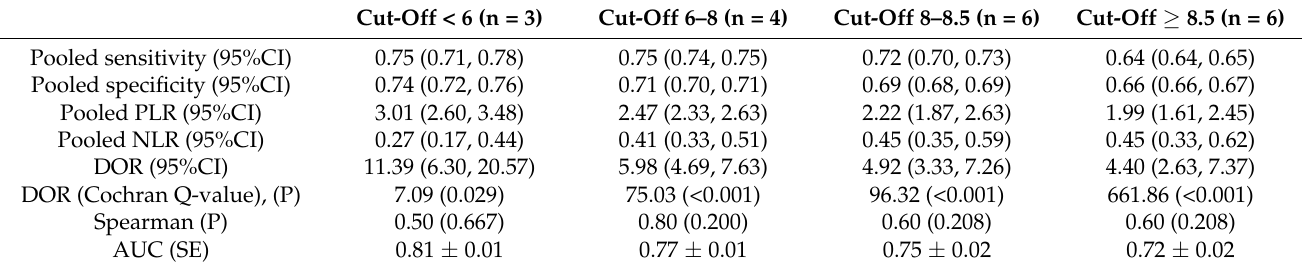
Table 4. Summary diagnostic accuracy at Various Diagnostic Thresholds for Diagnosis and Prediction for MAFLD.